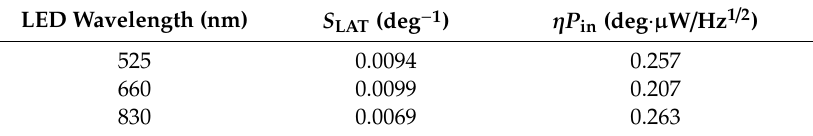
Table 1. Sensitivity and angular noise density at di ff erent light tag